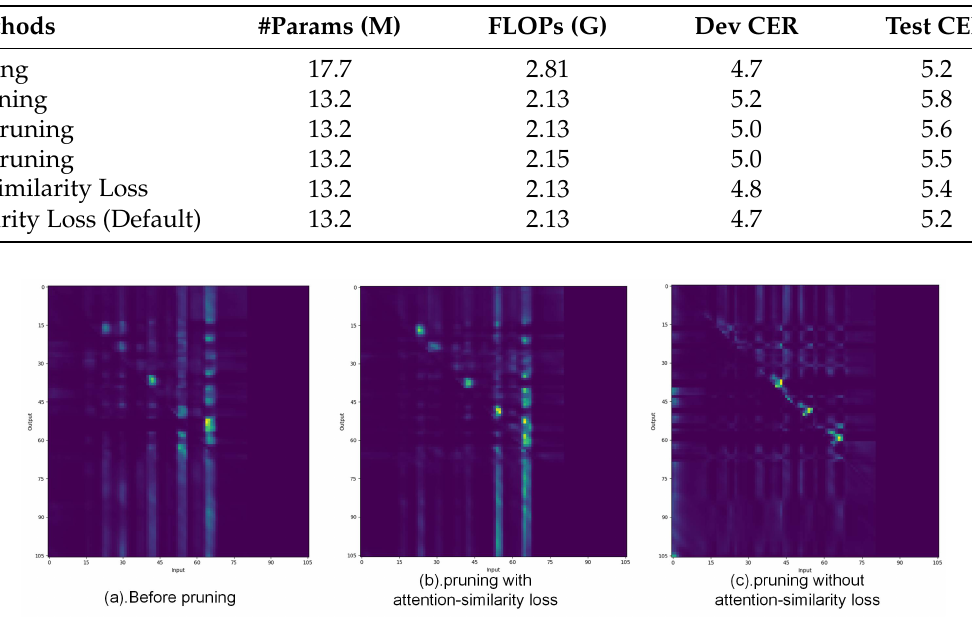
Table 4. The ablation studies of pruning algorithms on Aishell-1. For random pruning, structured l 1 -pruning and structured l 2 -pruning, we manually set the pruning ratio to ensure they have close pruning ratios for a fair comparison.